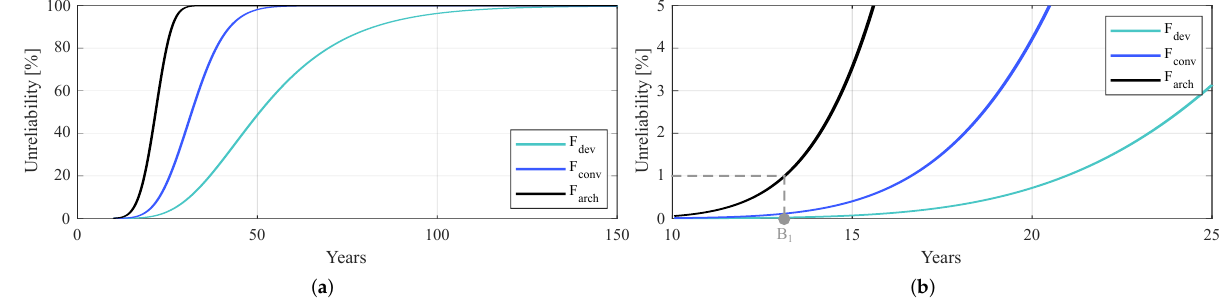
Figure 4. ( a ) Unreliability curves for an architecture formed identical converters based on a single device type, and, ( b ) zoomed curves where the B 1 parameter is